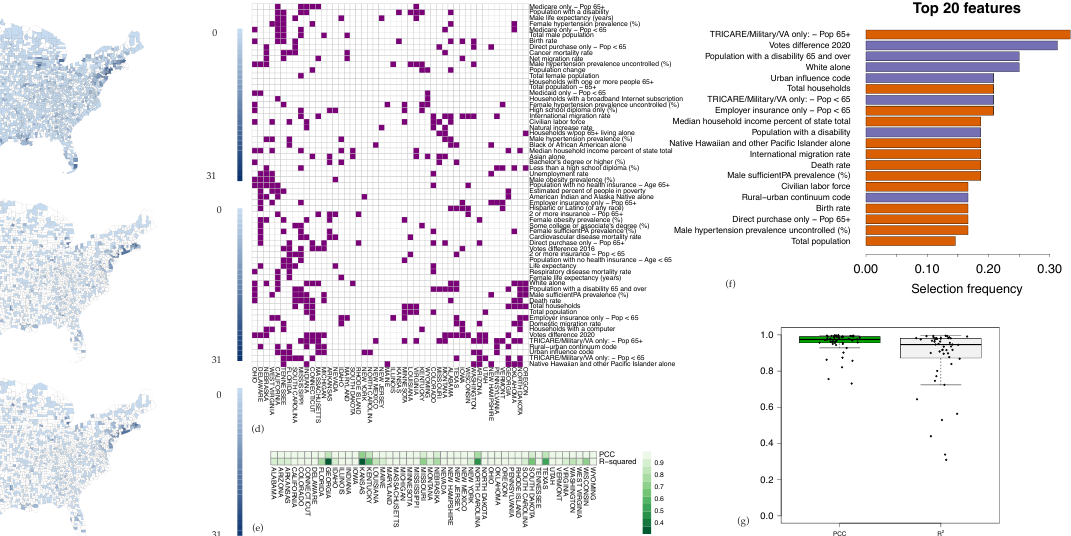
Figure A4. ( a – c ) On three different maps, we presented the data used for training our model for the initial phase prediction of deaths, the test data (i.e., holdback, observed) and our predictions for test locations. Deaths were aggregated over 30 days in each county in the maps. ( d ) Selected predictive features for each state. ( e ) PCC and R 2 values of the predictions reported as a heatmap per state. One can identify the states falling far from the observed versus predicted line from the accuracy heatmap. ( f ) The most predictive top 20 features selected overall by the algorithm for the initial phase. Purple-colored features are negatively correlated with the death counts and the orange-colored features are positively correlated with the case counts. ( g ) PCC and R 2 values of the predictions reported as a box